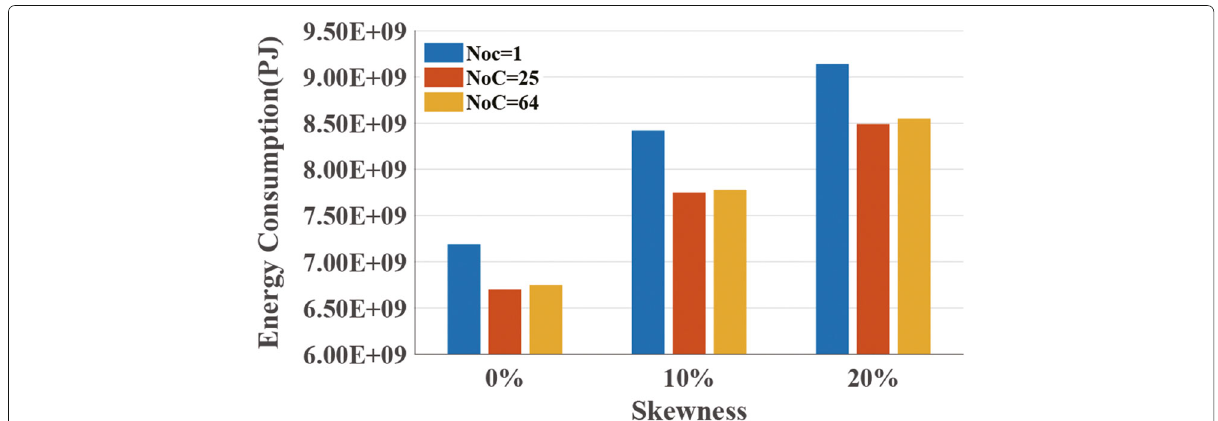
Fig. 7 The effect of skewness and the number of clusters on energy consumption when the cloud is located in the region-al boundary (100m, 50m). NoC represents the number of clusters in the IoT network